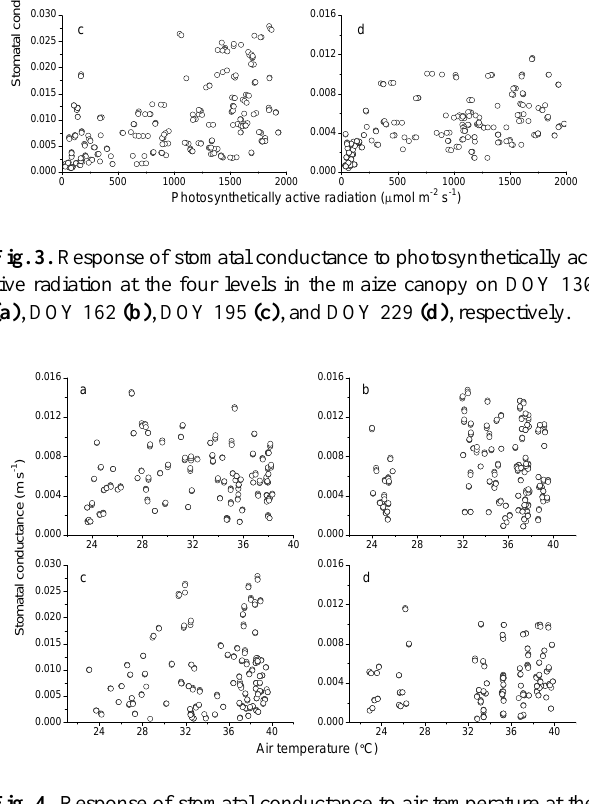
Fig. 4. Response of stomatal conductance to air temperature at the four levels in the maize canopy on DOY 130 (a) , DOY 162 (b) , DOY 195 (c) , and DOY 229 (d) , respectively.